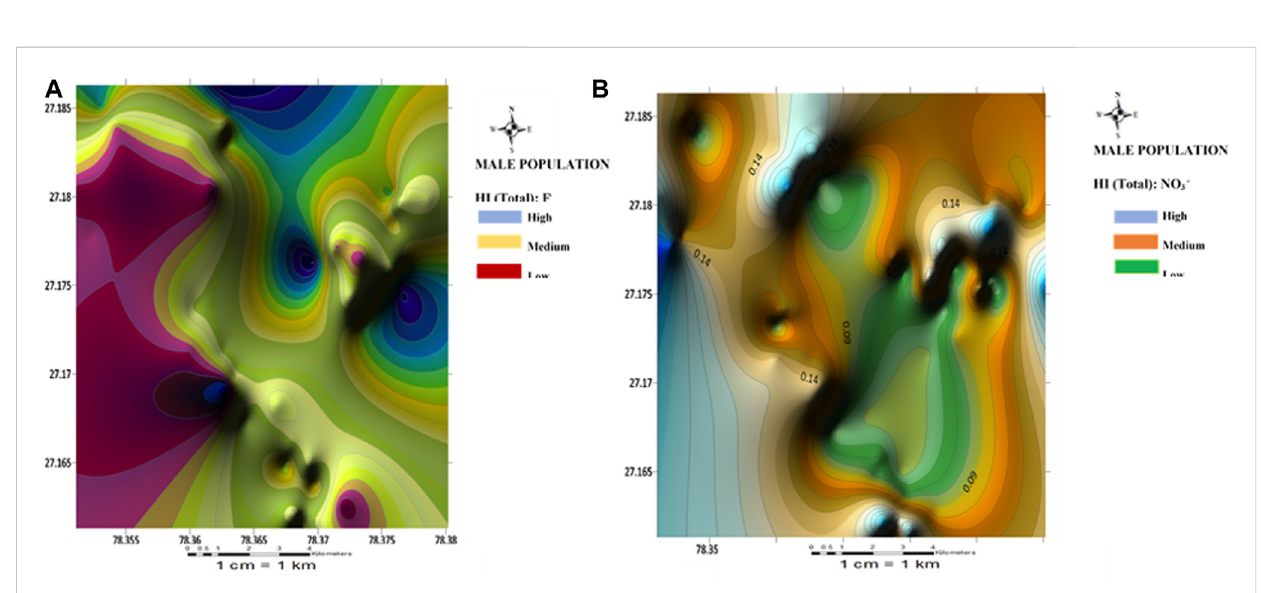
FIGURE 6 Spatial distribution health risk map of (A) fl uoride and (B) nitrate risk for male